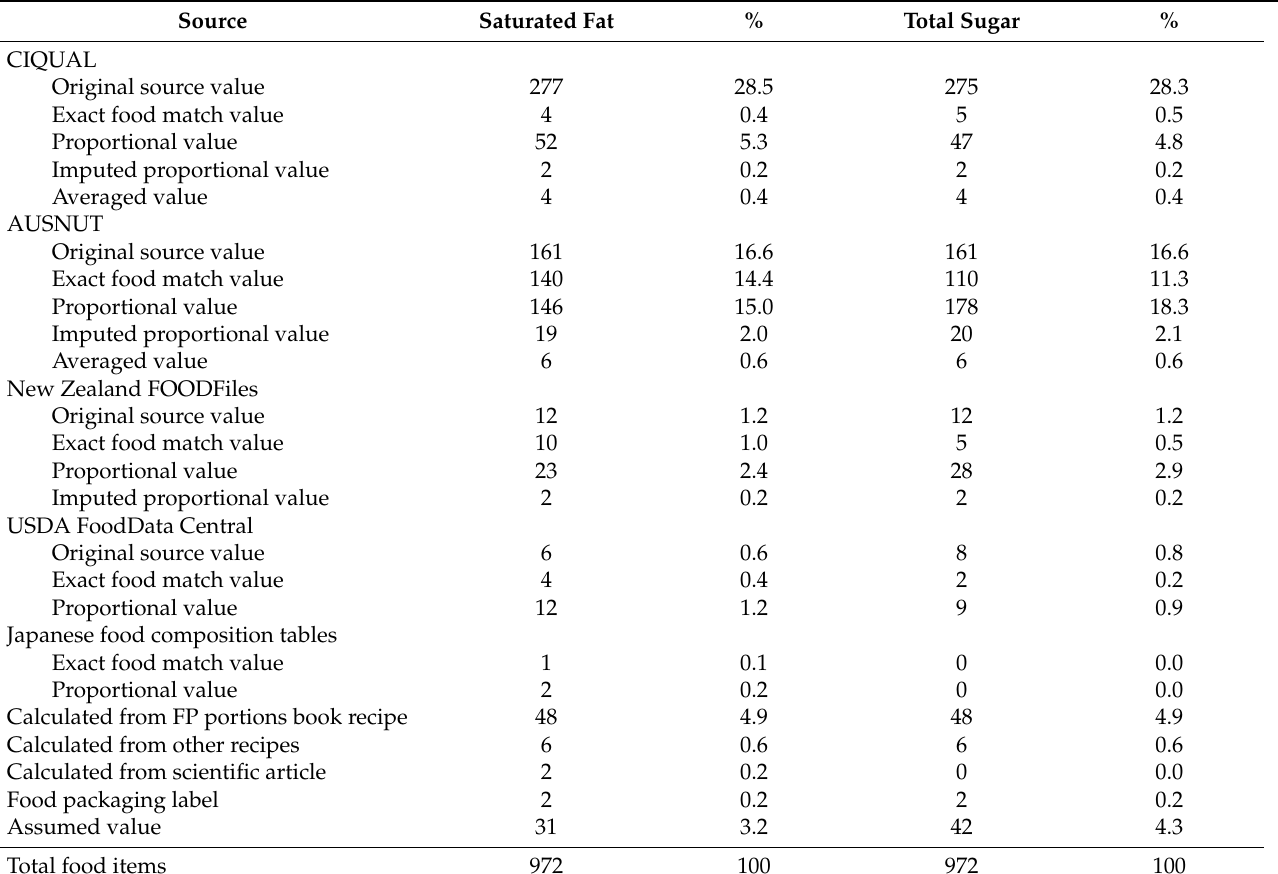
Table 3. Data sources for saturated fat and total sugar values for food items ( n = 972) in the New Caledonian food composition